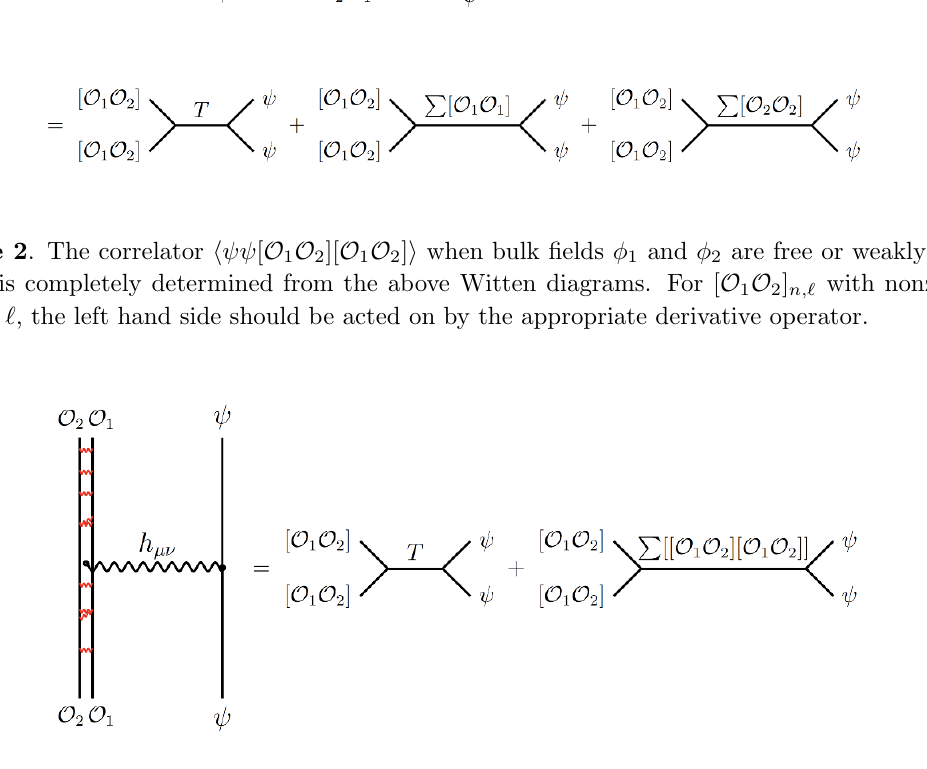
ψψ [ effectively behaves 1 2 ][ 1 2 ] h O O O O i